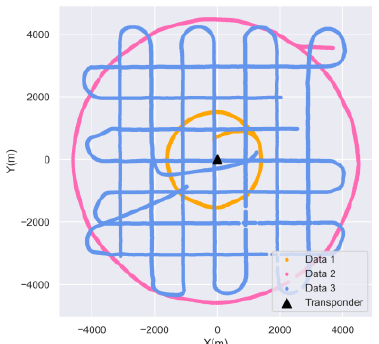
Figure 8 . The change of coordinate with phase.